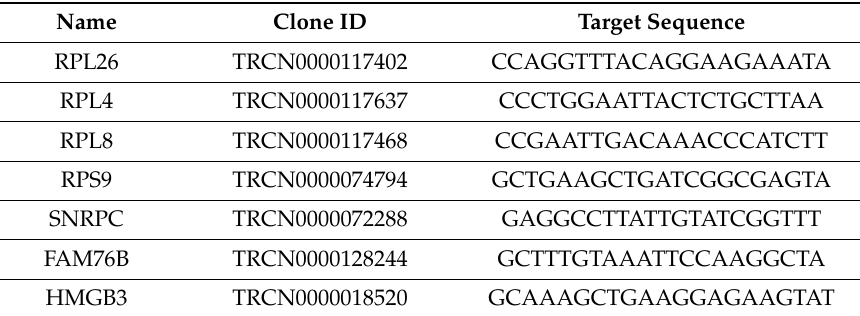
Table A3. shRNA lentiviruses obtained from a MISSION ® shRNA